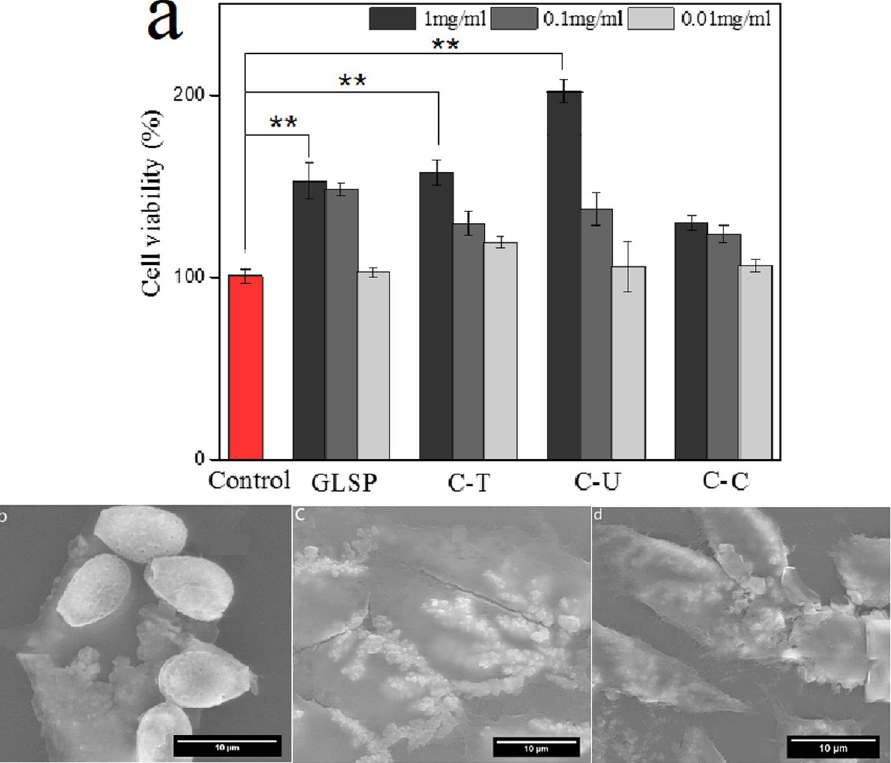
Figure 5. Cell viability evaluation. ( a ) Effects of GLSP/C-T/C-U/C-C with different concentration (1 mg/ mL, 0.1 mg/mL, 0.01 mg/mL) on the L 929 cell viability using CCK-8 assay ( b – d ) SEM images of L929 cell morphology treated by GLSP/C-U/C-T (1 mg/mL). Each treatment condition was repeated using 8 wells (96- well